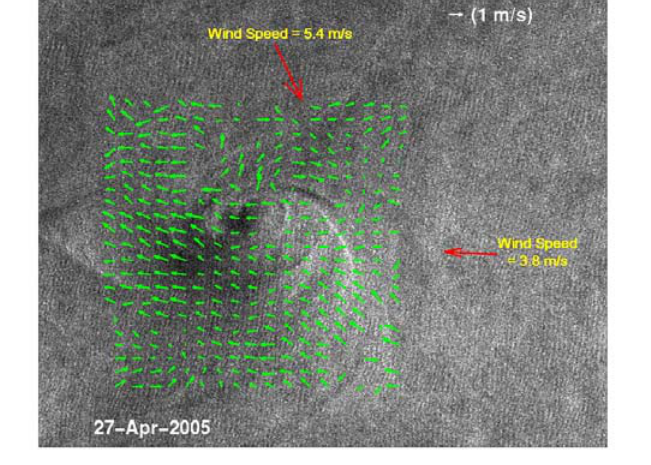
Figure 5. Ocean surface drift (green arrows) derived from ERS-2 and ENVISAT SAR data around the eddy area (ENVISAT image as background). The surface drift unit of 1 m/s is indicated by a white arrow at the top. The QuikSCAT wind data are shown as red arrows.